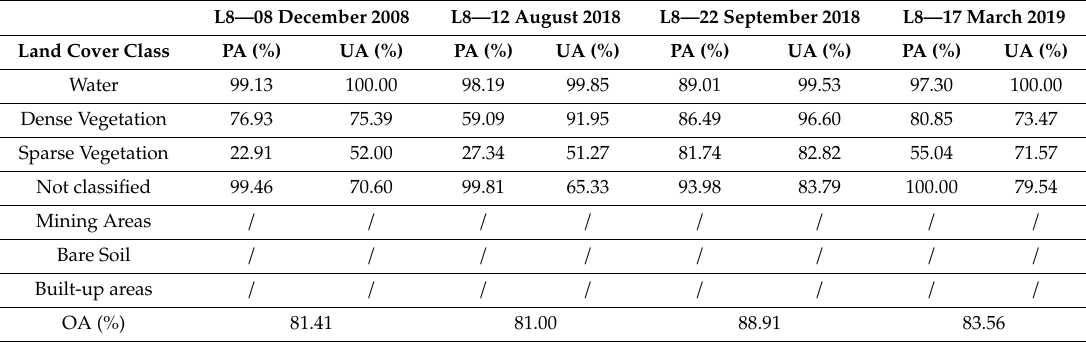
Table 6. OA, PA, and UA obtained through the application of Optimized Soil Adjusted Vegetation Index (OSAVI) on the data acquired by Landsat 8 mission. UA, user’s accuracy; PA, producer’s accuracy; OA, overall